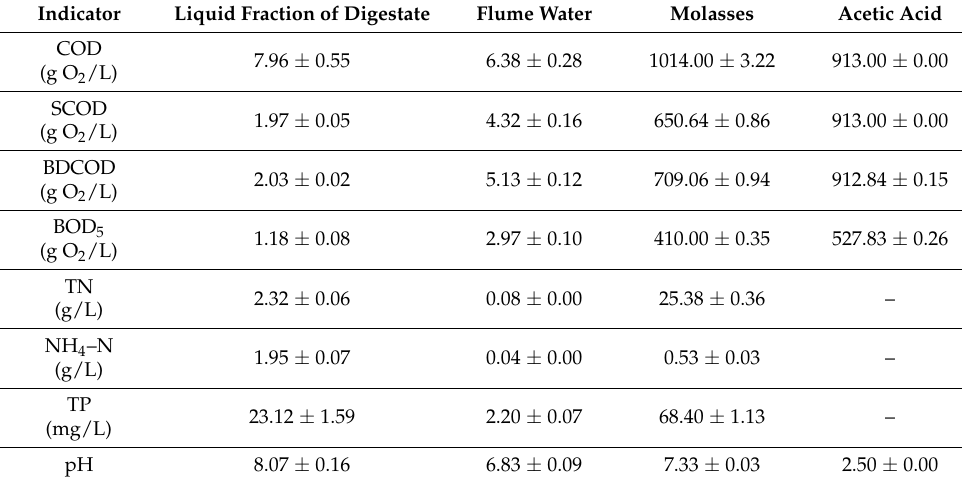
Table 1. Substrate